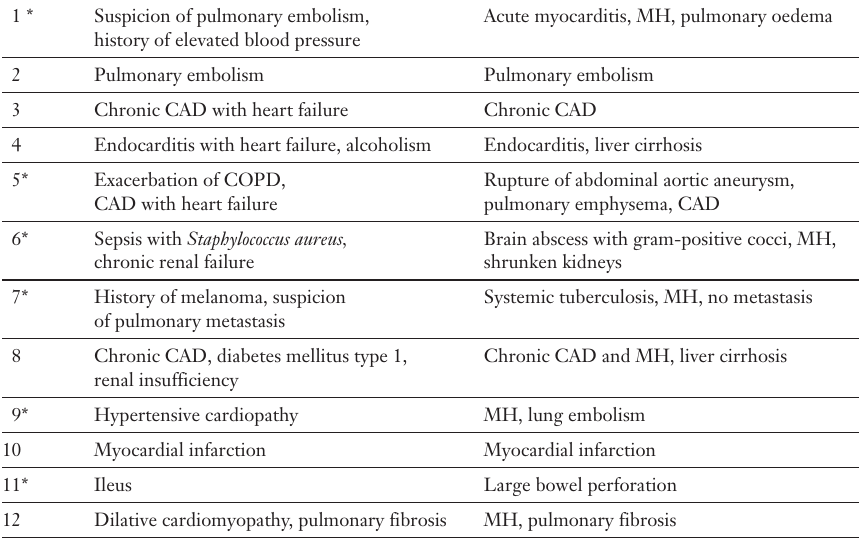
Table 3. Suspected diagnoses and autopsy findings of non-survivors. This table lists the 12 patients who did not survive resuscitation efforts and who un- derwent autopsy. The first column shows the clinical diagnoses before autopsy and the second column shows the autopsy findings. In the patients marked with * a relevant new diagnosis could be identified by